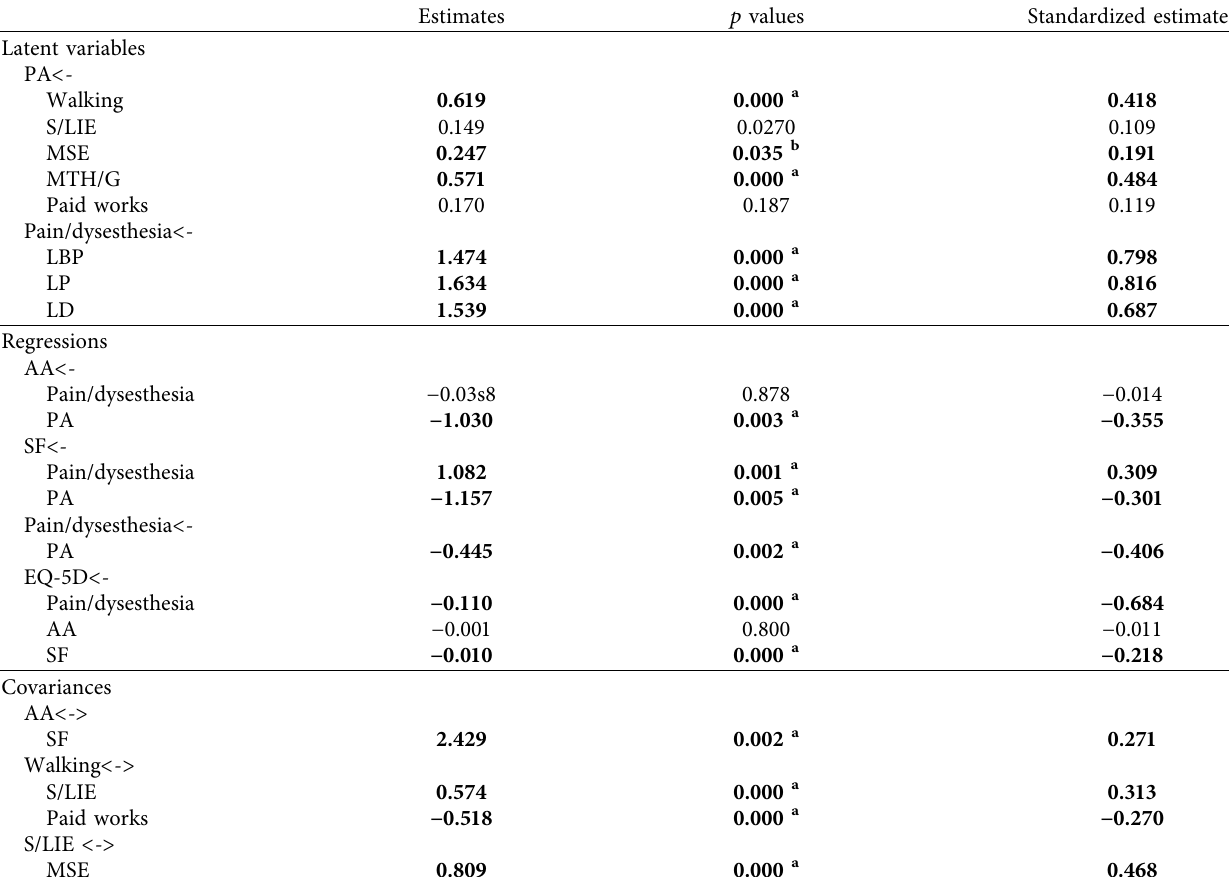
Table 2: Estimates and standardized estimates obtained by the WLSMV